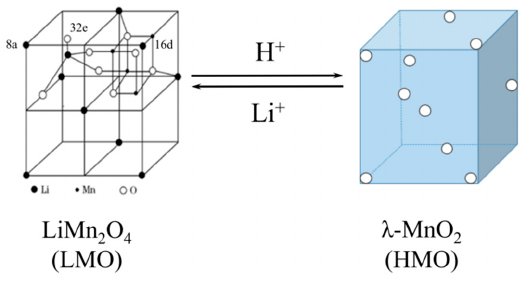
Figure 1. Illustrated microstructures of LiMn 2 O 4 and λ -MnO 2 .